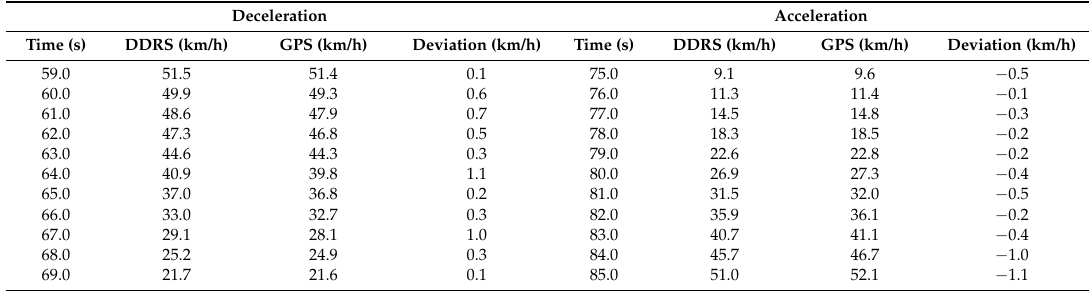
Table 5. Numerical results of speed-measuring values of the GPS speed sensor and the DDRS during deceleration and